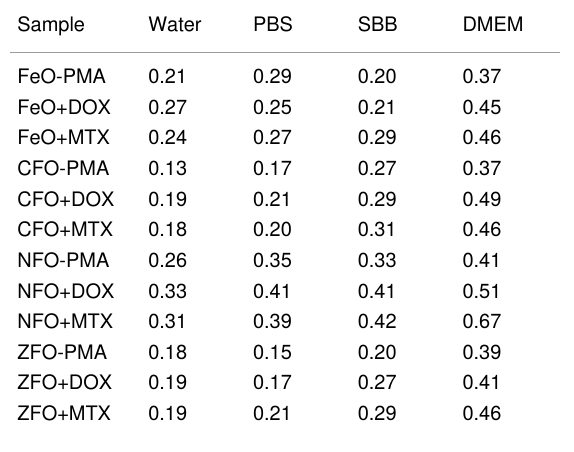
Table 5: PDI values of MFe 2 O 4 (M = Fe, Co, Zn, Ni) NPs by